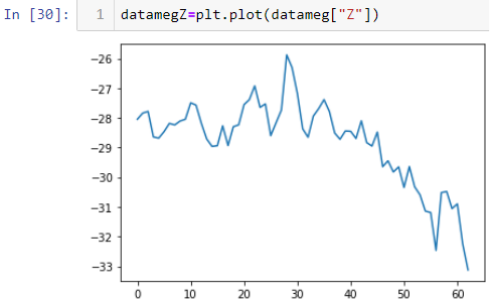
Figure 50. Magnetic z -axis data, showing a spike in the middle.